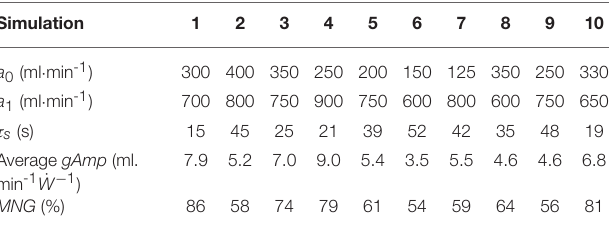
TABLE 2 | Description of the parameter used for the computer simulations and the parameters obtained by frequency-domain analysis. Simulation